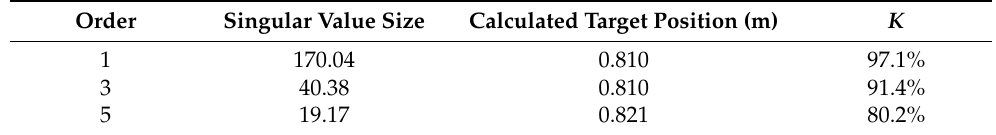
Table 1. Survivor location information based on energy entropy.